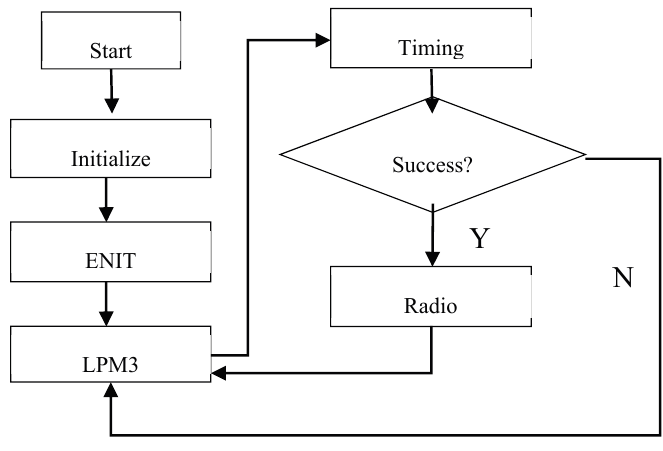
Figure 9. Flow chat of the measurement process.